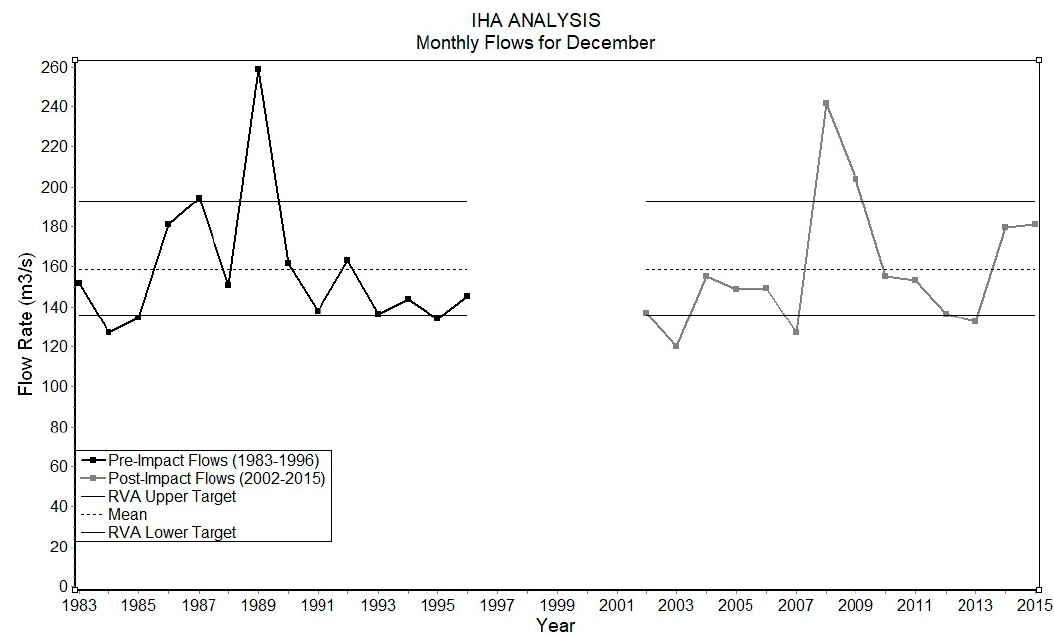
Figure A2. RVA analysis for mean monthly flow of December.